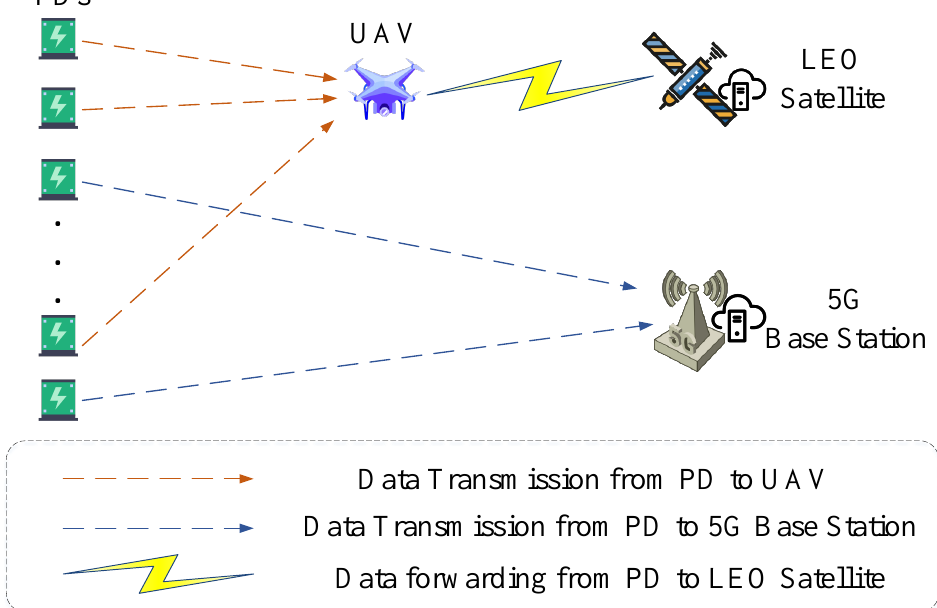
Figure 2. Communication mode of components participating in Figure